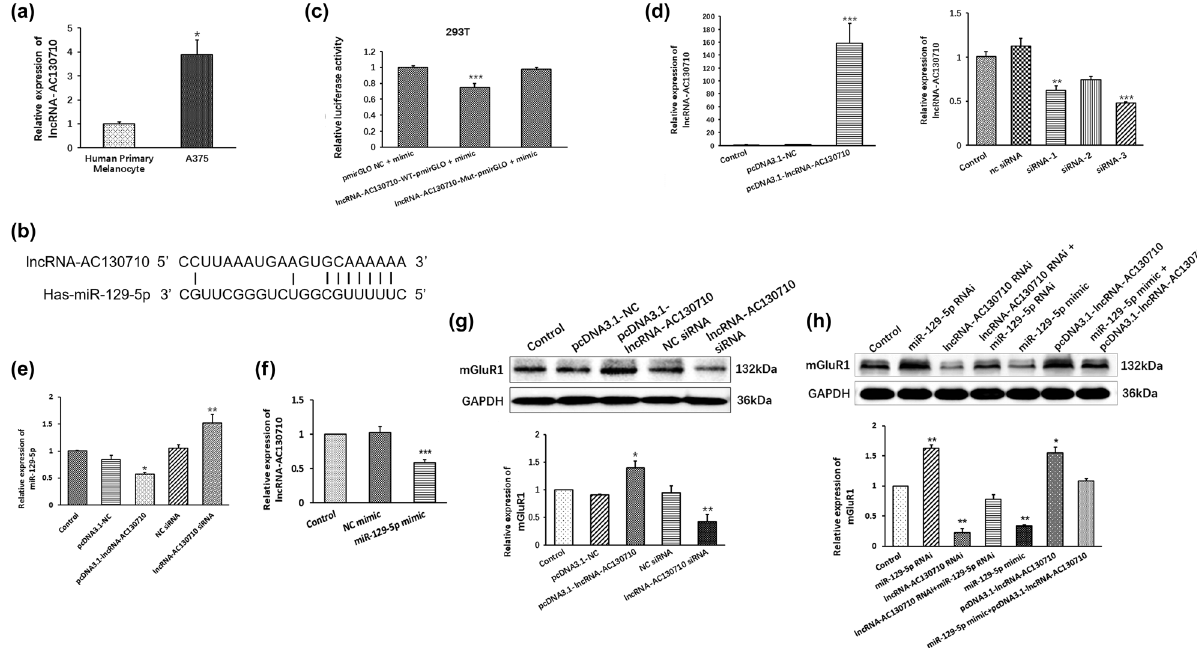
Figure 3: lncRNA - AC130710 directly target with miR - 129 - 5p in A375. ( a ) Relative expression of lncRNA - AC130710 in A375 cells compared with human primary melanocytes cell line. ( b ) Predicted complementary binding site of miR - 129 - 5p in lncRNA - AC130710. ( c ) Relative luciferase activities were inhibited transfected with the reporter vector WT lncRNA - AC130710, not with the reporter vector Mut lncRNA - AC130710. ( d ) Construction of pcDNA3.1 - lncRNA - AC130710 and lncRNA - AC130710 siRNA vectors. ( e ) Relative expression of miR - 129 - 5p in A375